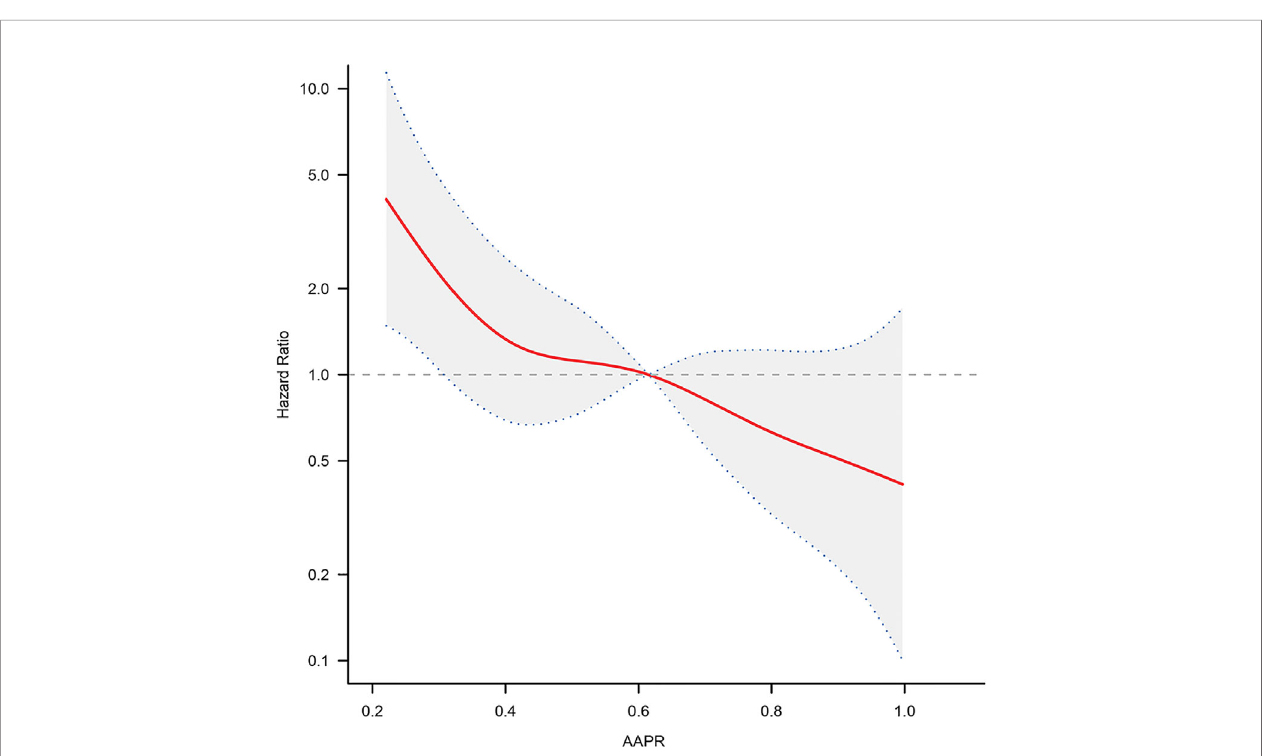
FIGURE 3 | The adjusted smooth fi tting curve between pretreatment AAPR and OS of BC patients based on two-piece-wise regression model. A linear relationship between AAPR and OS was observed. The red solid line and blue dashed line represent the estimated values and their corresponding 95% con fi dence intervals. OS, overall survival; AAPR, albumin-to-alkaline phosphatase ratio; BC, bladder